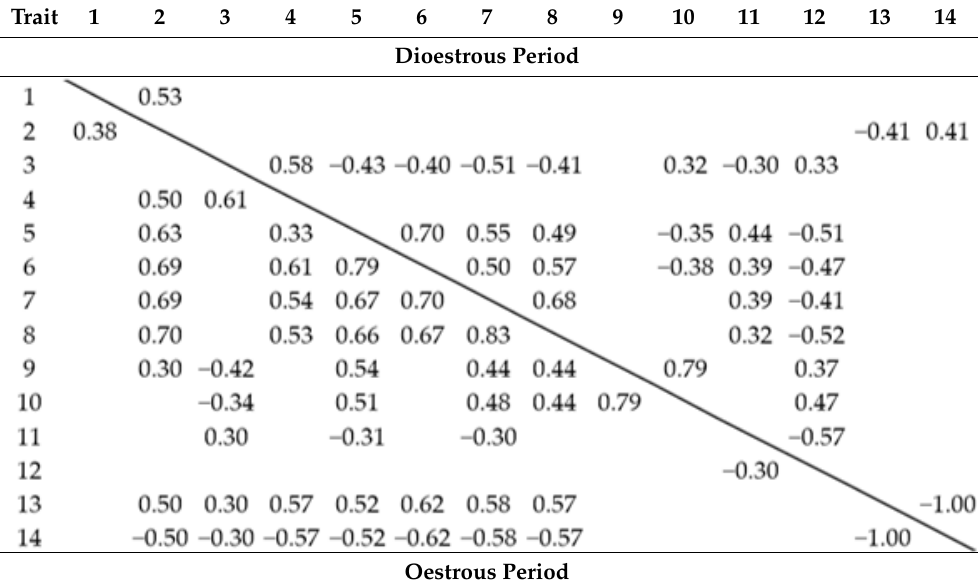
Table 5. Significant correlations ( p < 0.05) between traits: bottom—during oestrus period, top—during dioestrus